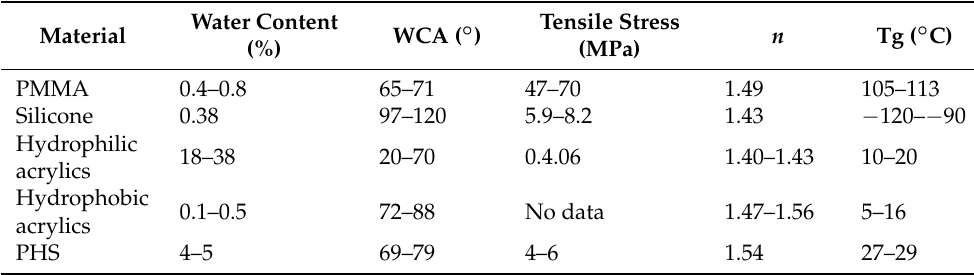
Table 5. Relevant physical properties for conventional IOL materials. Data from New Hydropho- bic IOL Materials and Understanding the Science of Glistenings, Tetz, M.; Jorgensen, M.R. Curr Eye Res 2015, 40, 969–981 [23], reprinted with permission of the publisher (Taylor & Francis